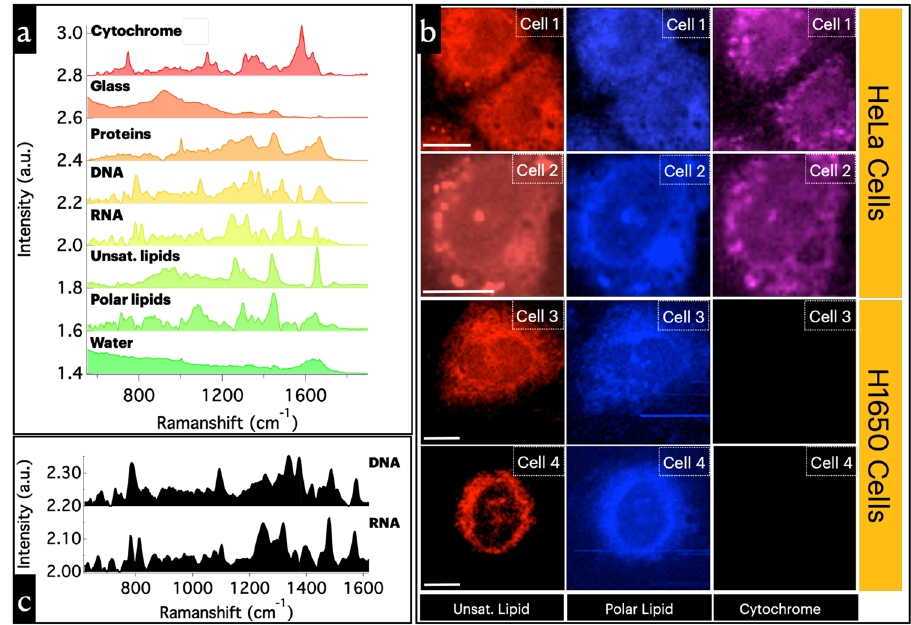
Fig. 1 Results of multivariate data deconstruction using MCR-ALS. a MCR spectral components. b Raman images corresponding to cytochromes ( b and c ) and lipids in two different cell lines. Lipid droplet-like lipid enriched regions can be seen in Raman images corresponding to unsaturated lipids. c Raman spectral components corresponding to DNA and RNA (for details, see Supplementary Note 1 and Figs. S2 – S8). Scale bars 10 µ m.